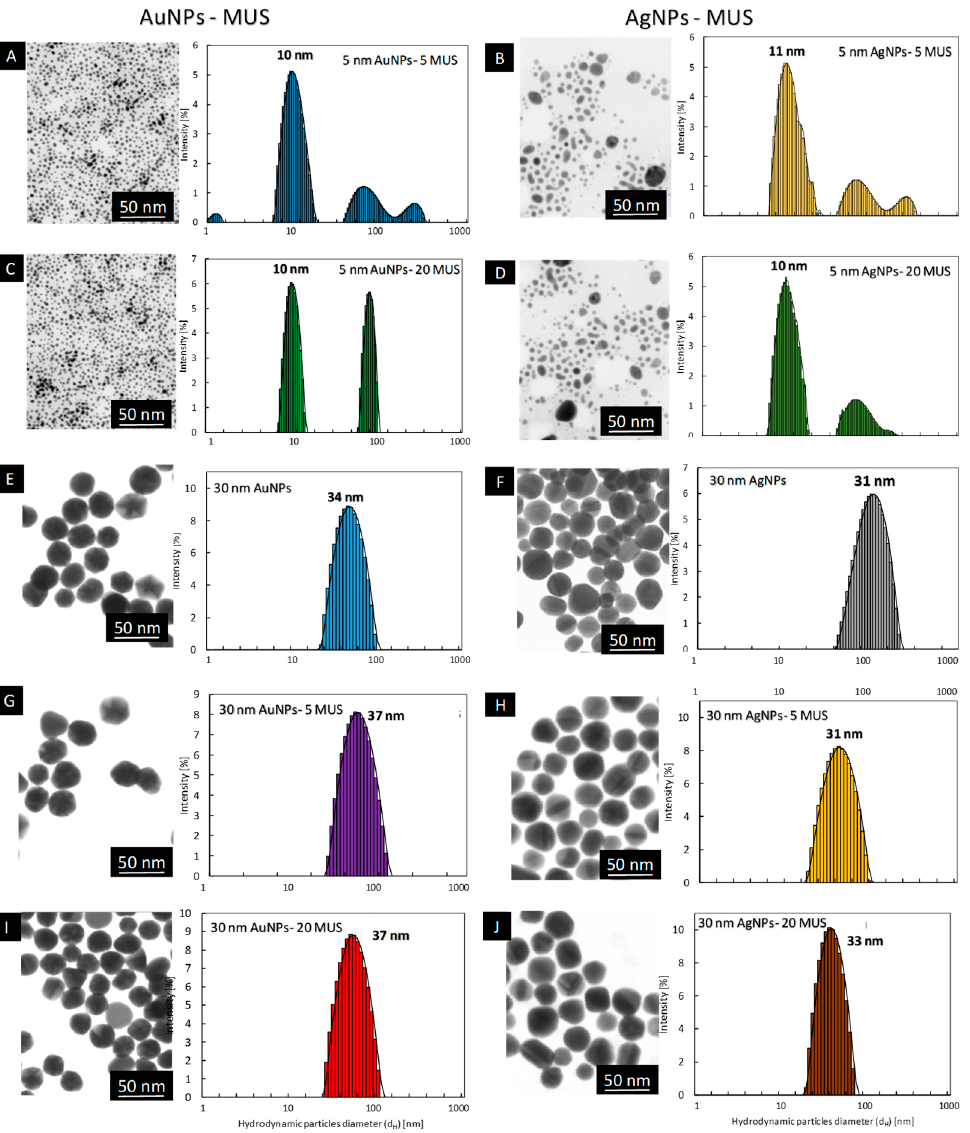
Figure 3. STEM images and DLS size distribution histograms of sulfonate-conjugated metallic nanoparticles: 5 nm AuNPs-5MUS ( A ); 5 nm AgNPs-5MUS ( B ); 5 nm AuNPs-20MUS ( C ); 5 nm AgNPs-20MUS ( D ); 30 nm AuNPs ( E ); 30 nm AgNPs ( F ); 30 nm AuNPs-5MUS ( G ); 30 nm AgNPs-5MUS ( H ); 30 nm AuNPs-20MUS ( I ); 30 nm AgNPs-20MUS ( J ).